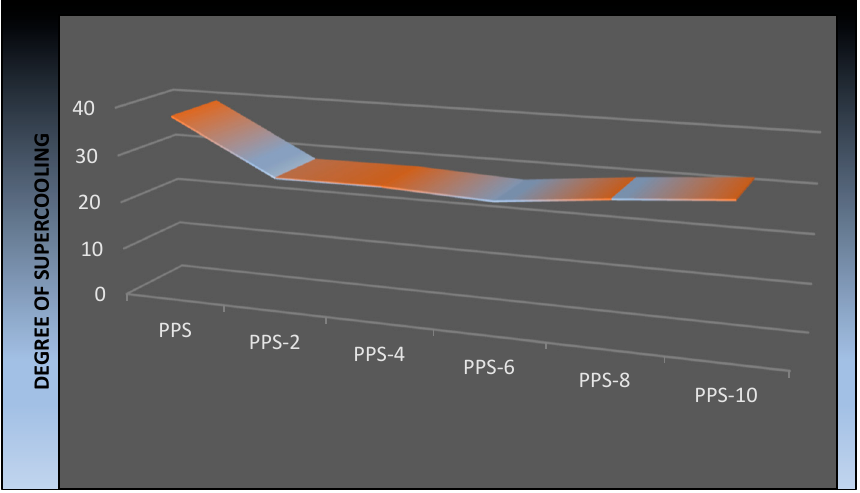
Polymers 2023 , 15 , x FOR PEER REVIEW Figure 11. Graphic illustration of the change in the degree of supercooling of the PPS@BC nanocomposites.